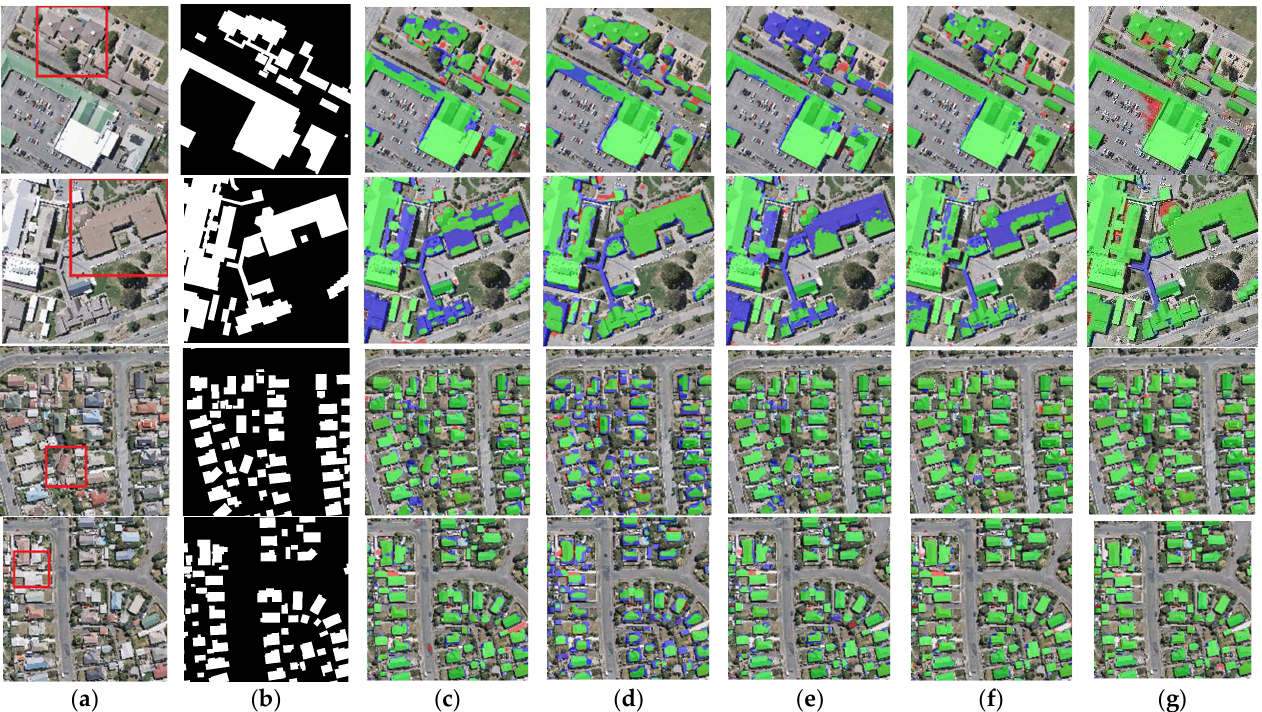
Figure 8. Examples of building extraction results obtained by different networks on the WHU dataset. ( a ) Original image. ( b ) Ground-truth. ( c ) FCN8s. ( d ) DANet. ( e ) SegNet. ( f ) U-Net. ( g ) BGC-Net. Note, in Columns ( b – g ), black, white, green, blue, and red indicate true, false, true-positive, false-negative, and false-positive, respectively. The red rectangles in ( a ) are the selected regions for close-up inspection in Figure 8.